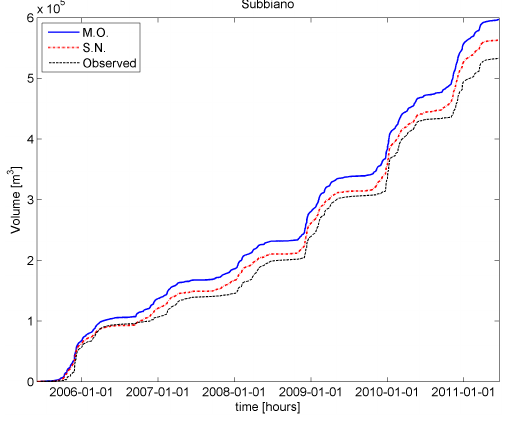
Figure 17. Accumulated runoff volumes of the Casentino basin ob- tained with the M. O. and S. N. parameter sets for the period 2005– 2011. Time is reported on x axis and total accumulated volume on y